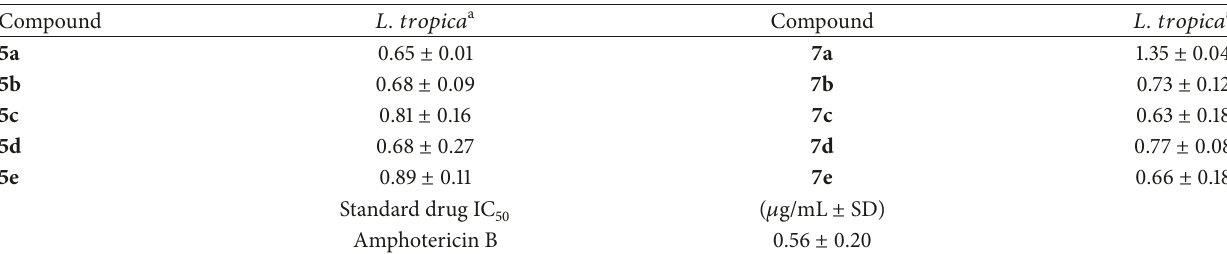
Table 3: % inhibition of compounds 5a – e and 7a – e against L. tropica leishmania .